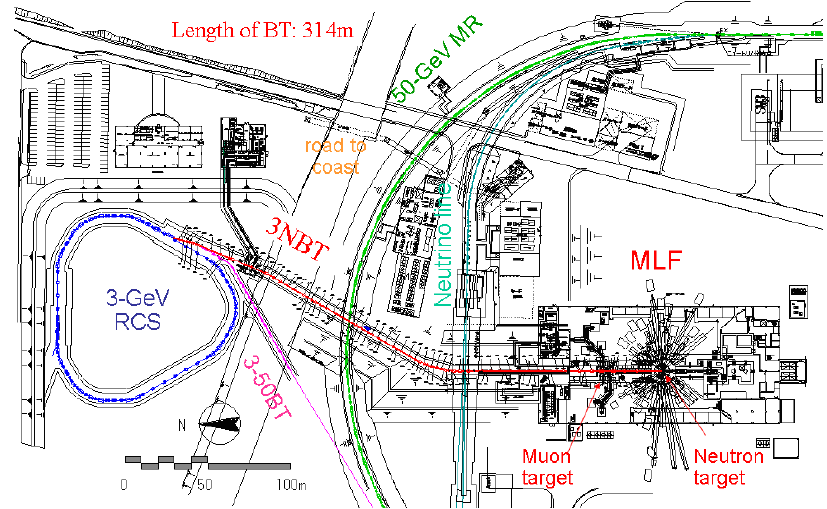
Figure 17. Plan view of the 3 GeV Rapid Cycling Synchrotron (RCS), the 3 GeV RCS to Neutron facility Beam Transport (3NBT) and the MLF at J-PARC.